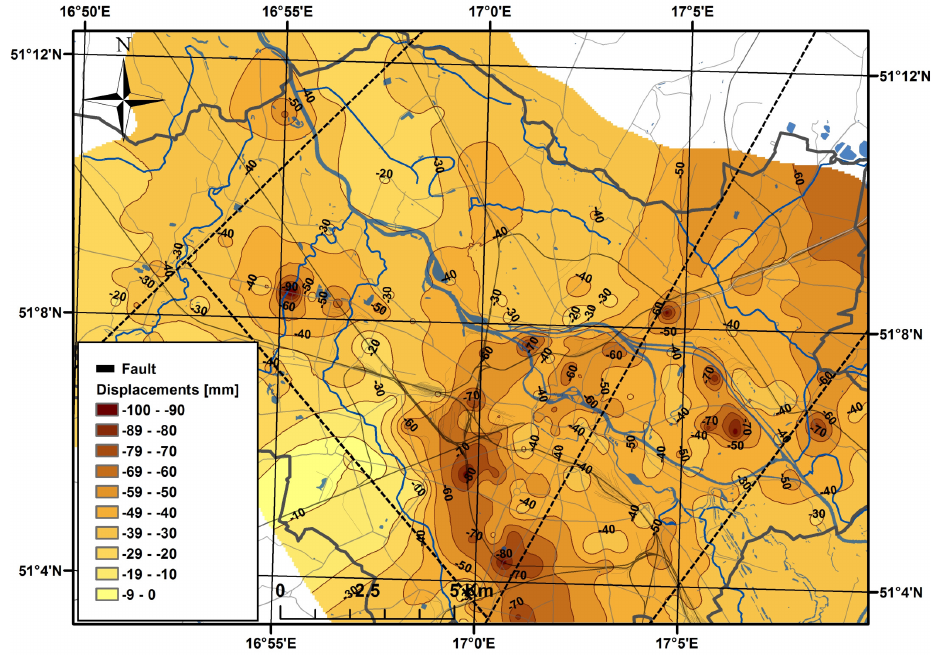
Figure 5. Relative vertical displacements in the 1930–1998 period